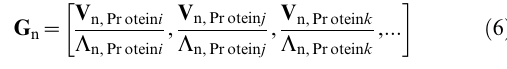
Figure S1 The RMSD versus time plot for experimental structures of AncCR and AncGR2. Figure S2 The Mean Square Displacement between our predicted structures for AncCR-AncGR1 (blue), AncCR-AncGR2 (green), and AncGR1-AncGR2 (red). Figure S3 The plot of most collective mean square fluctuation of different sliding windows. Figure S4 The dynamics of the experimental AncCR, AncGR1, and AncGR2 structures plotted in a reduced subspace. Figure S5 Plot and ribbon diagram of the dynamics of the single mutation variant of human ferritin protein characterized by the slowest collective mode. Figure S6 Radius of gyration of the hydrophobic residues versus the RMSD from the experimentally determined structure of AncCR for a single FRODA run. Table S1 RMSD from Native Before and After REMD